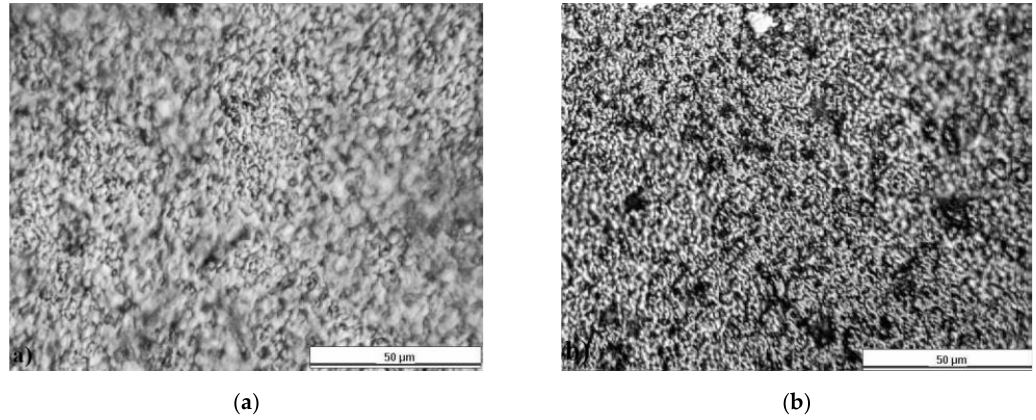
Figure 8. Representative optical micrographics: ( a ) TiN coating; ( b ) TiAlN coating.